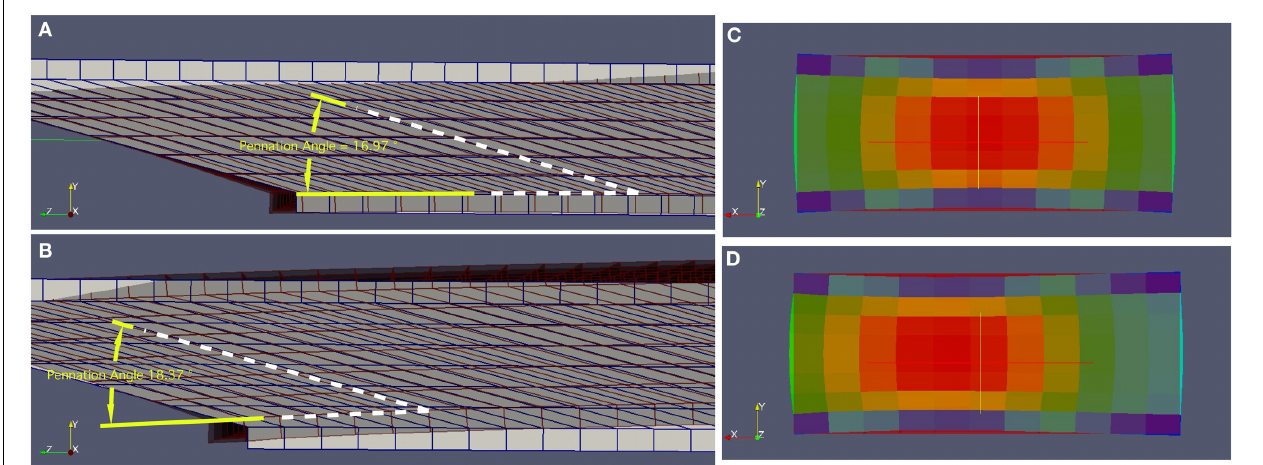
the undeformed shape is shown by the rectangular and dark red area. The colored elements show the magnitude of the strain in the model tissues in their deformed state, ranging from low strains (blue) in the aponeurosis to greatest strains (red) in the muscle belly. Note how the muscle belly thickness between the aponeuroses is least over the active region of fibers, and the width of the muscles has increased beyond the undeformed state. Also note that in the Medial-lateral activation pattern the maximum strains have moved laterally (to the left) within the